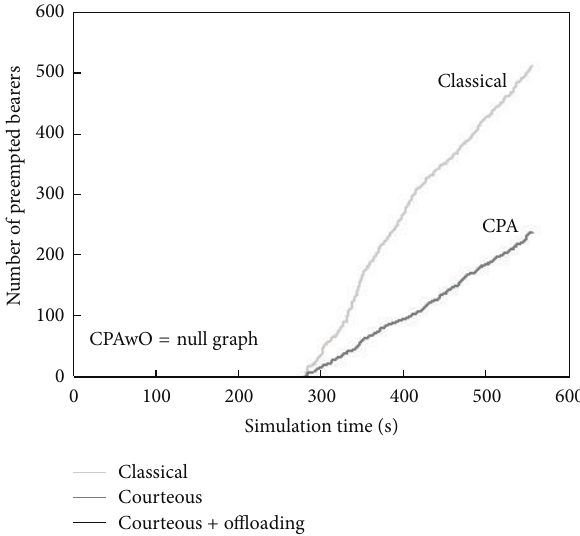
Figure 11: Number of CN nonemergency preempted